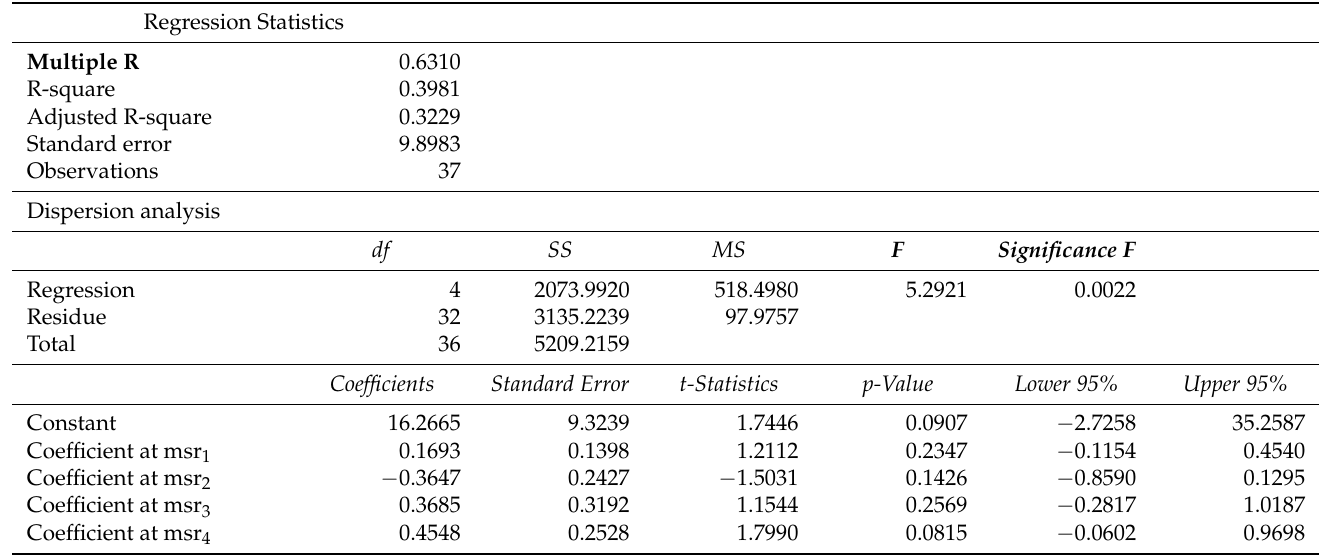
Table 5. Dataset modelling the impact of the specific factors of sustainable development financing on social entrepreneurship. Regression